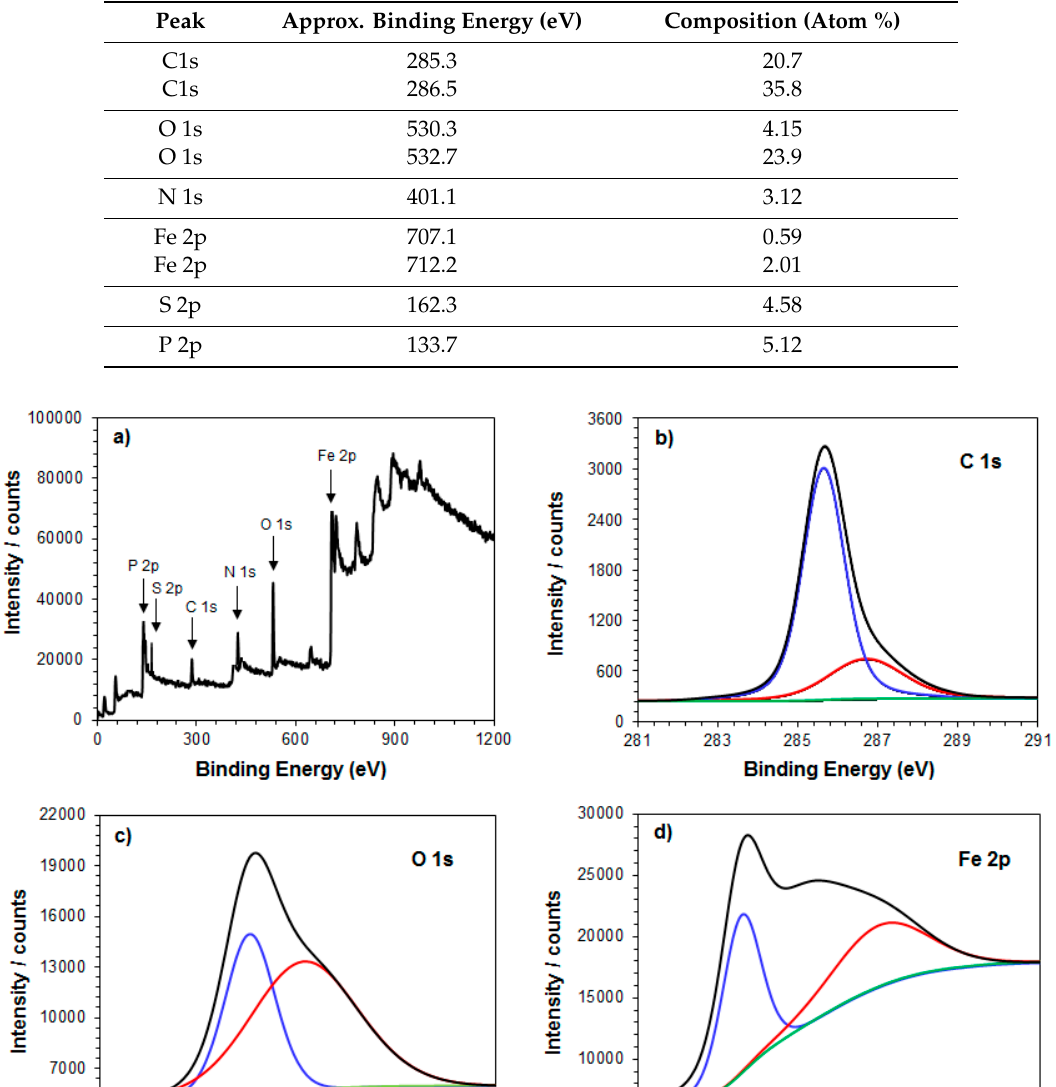
Table 7. XPS scan composition of Fe immersed in inhibited solution of 1 M HCl at 333 K for 6 h.